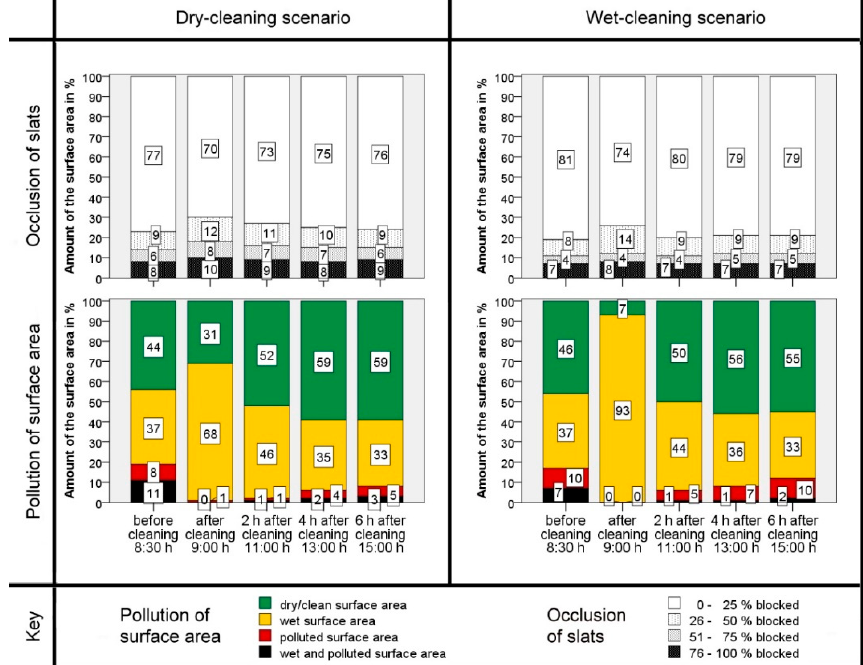
Figure 5. Results of the cleaning performance of the robot scraper before cleaning and at different intervals after cleaning for the cleaning runs in the morning (Start: 8:30 h): Proportion of occluded slots (above) and degree of polluted surface area (below) for both cleaning scenarios, dry-cleaning (left) and cleaning with the use of water (right). The numbers in the bars indicate the respective percentage of the total floor area of the experimental compartment. Animals 2019 , 9 , x FOR PEER REVIEW